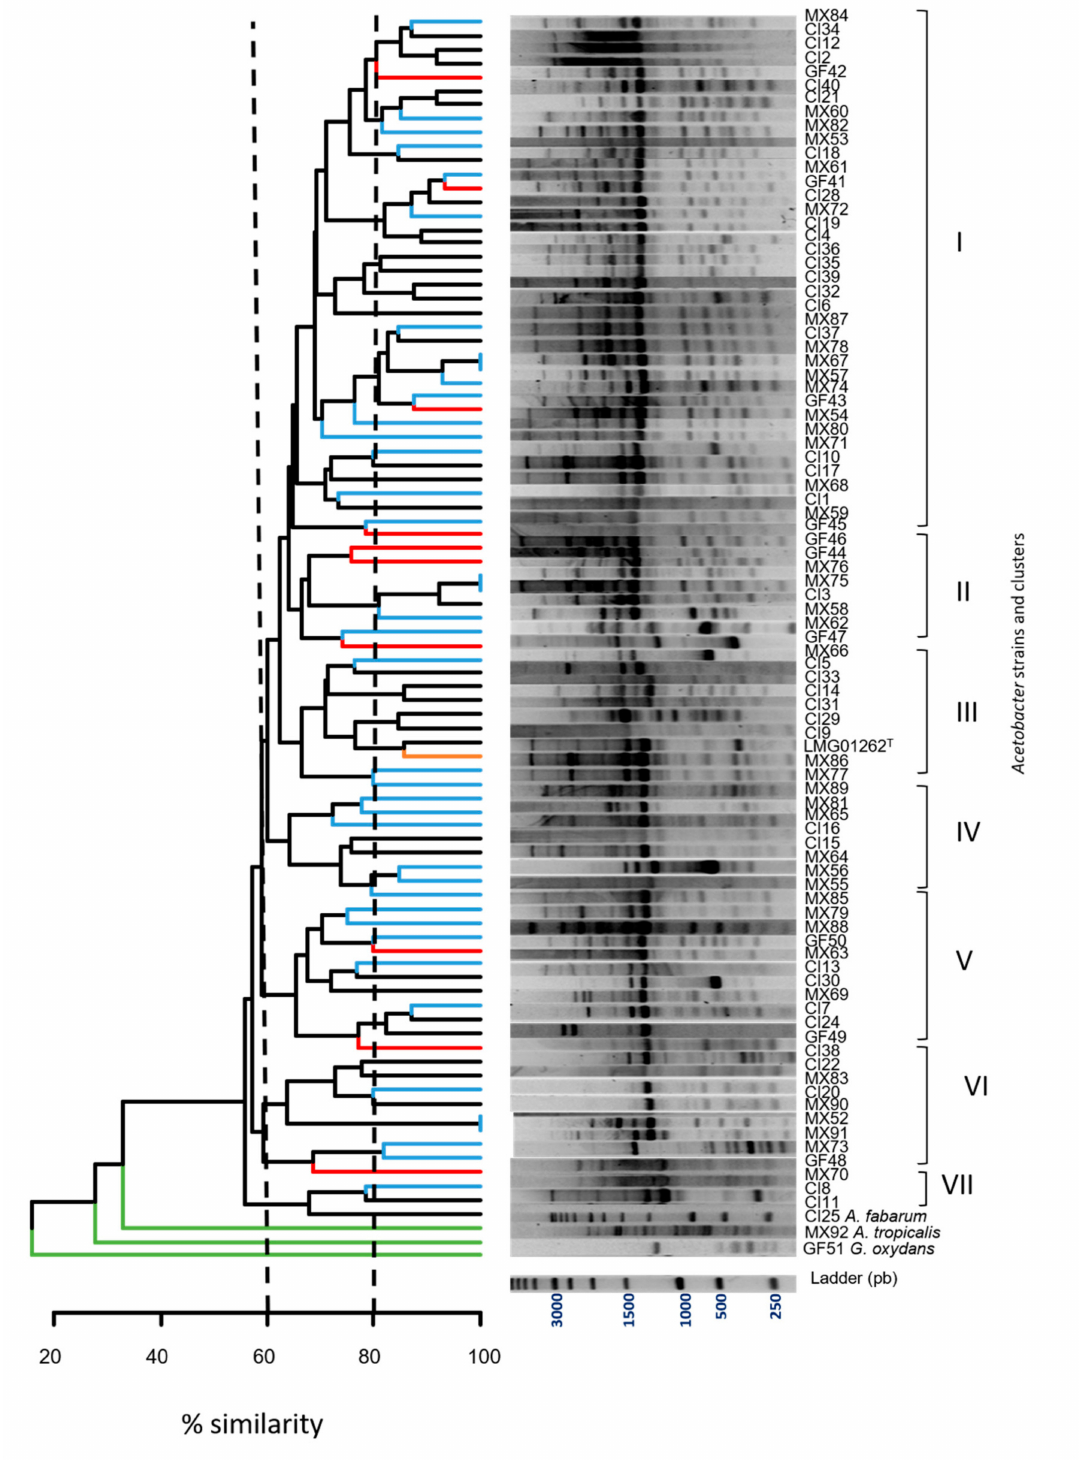
Figure 3. (GTG) 5 PCR banding patterns and the dendrogram generated after the statistical analysis of the similarity of the banding patterns of the 86 Acetobacter pasteurianus , and three AAB— Acetobacter fabarum , Acetobacter tropicalis and Gluconobacter oxydans —strains isolated from spontaneous cocoa fermentations in three areas around the world, and one A. pasteurianus -type strain (LMG0162 T ). The Sørensen–Dice index was used to analyze the similarity, and a UGPMA clustering algorithm was applied to cluster the data. The tree branch colour code is identical to that in Figure